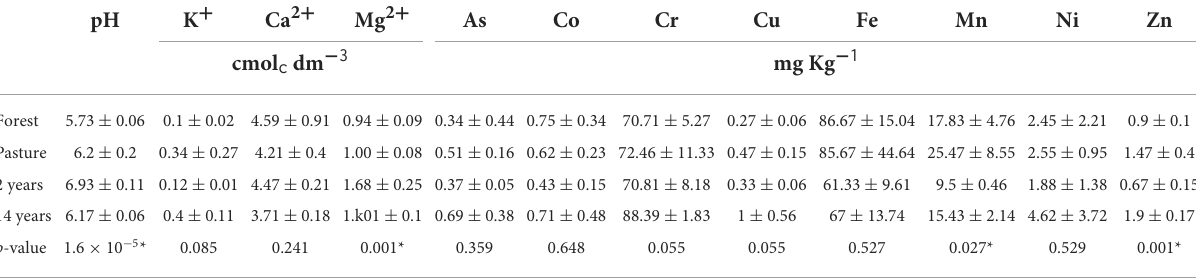
TABLE 1 Chemical characteristics were obtained from soil analysis, pH values, micronutrient contents, and heavy metals. pH K + Ca 2 + Mg 2 + As Co Cr